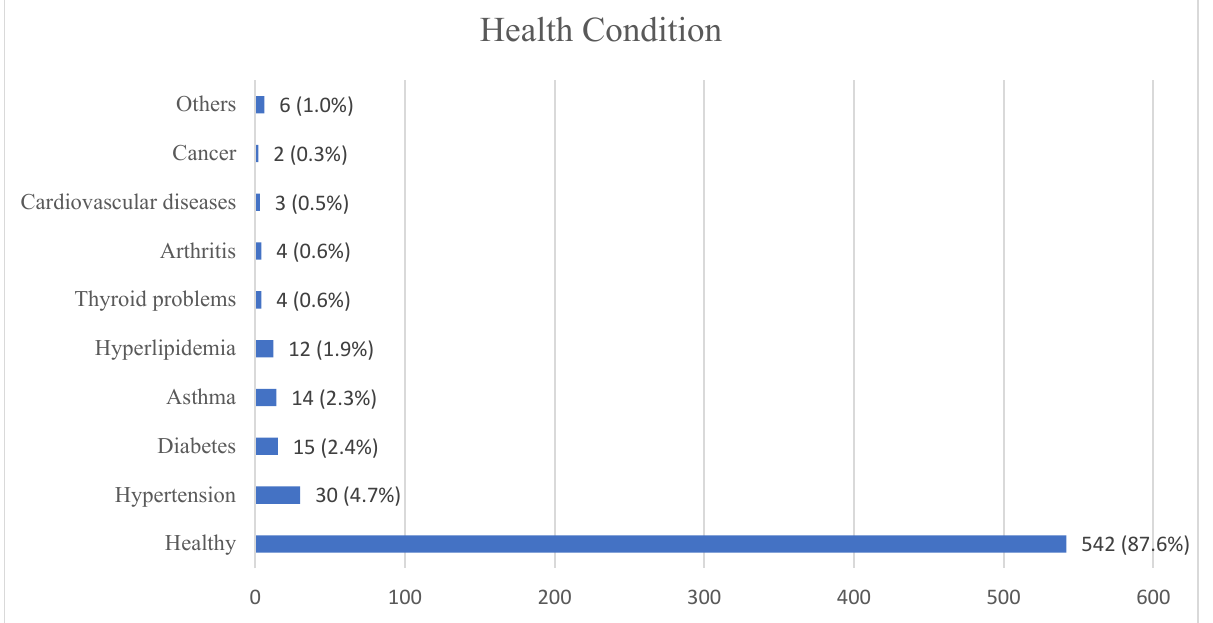
Figure 1. Health conditions of the study participants.